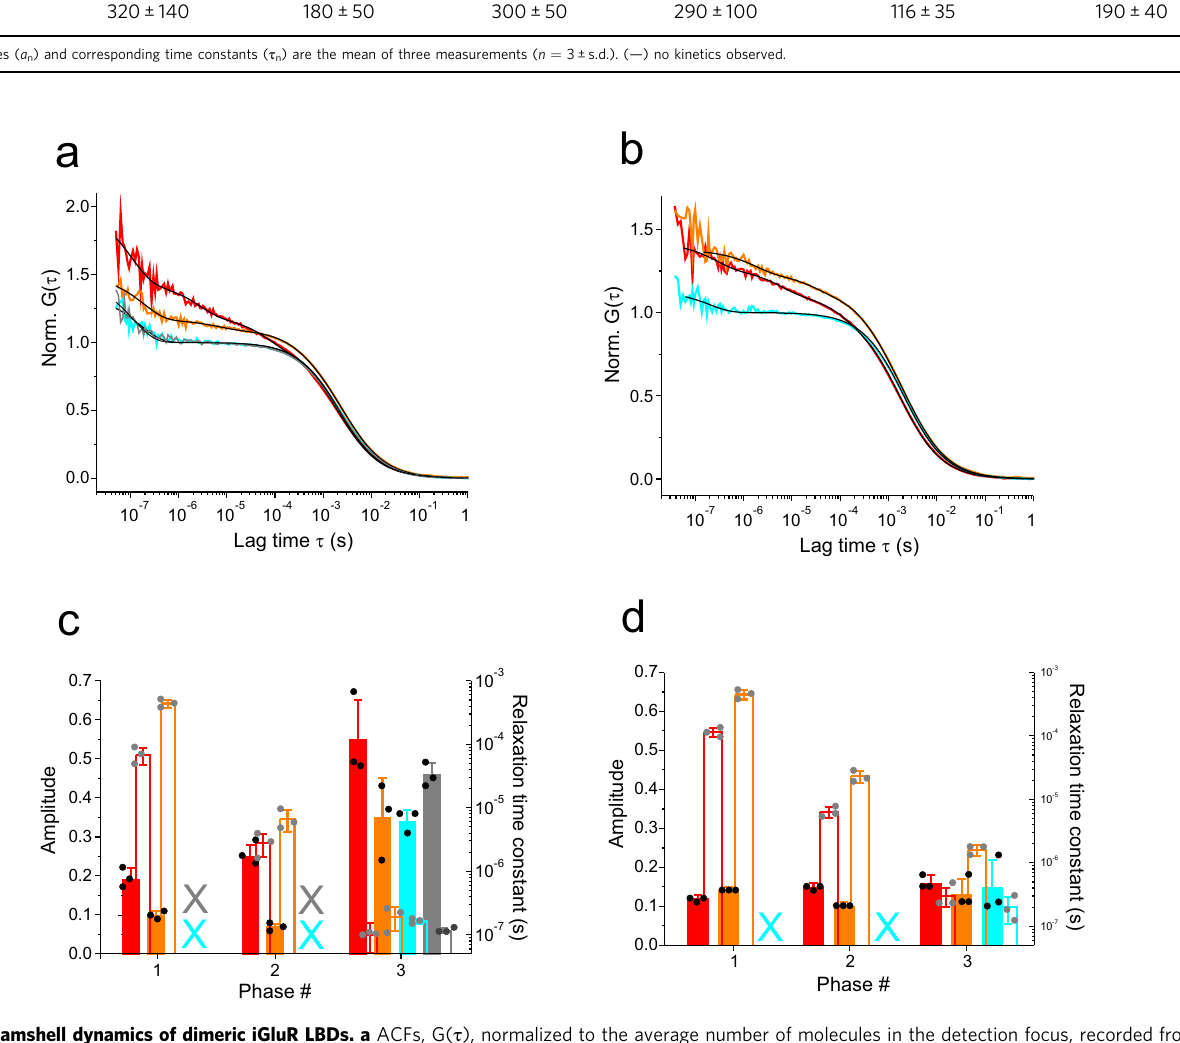
Fig. 4 Clamshell dynamics of dimeric iGluR LBDs. a ACFs, G( τ ), normalized to the average number of molecules in the detection focus, recorded from GluA2-LBD-G446C-T685W-L483Y (apo monomer, red) and in presence of excess GluA2-LBD-L483Y (apo dimer, orange). ACFs of the dimer in presence of the agonists Glu and AMPA are shown in cyan and gray (agonist-bound dimers). b ACFs recorded from GluN1-LBD-A480C-N521Y (apo monomer, red) and in presence of excess GluN2A-LBD-E516Y (apo hetero-dimer, orange). The ACF of the GluN1-GluN2A hetero-dimer in presence of the agonist Gly is shown in cyan. Black lines are fi ts to the data using a model for molecular diffusion containing a sum of one to three single-exponential decays (indicated in ( c , d )). c Amplitudes (closed bars) and corresponding time constants (open bars) of exponential decays of ACFs of the monomeric and dimeric GluA2 LBD in apo and agonist bound states. Data sets and color code correspond to the ACFs shown in panel ( a ). Crosses (X) denote missing (not detected) kinetics. d Amplitudes (closed bars) and corresponding time constants (open bars) of exponential decays of ACFs of the monomeric and hetero-dimeric GluN1 LBD in apo and agonist-bound states. Data sets and color code correspond to the ACFs shown in panel ( b ). Crosses (X) denote missing (not detected) kinetics. Error bars are s.d. of three measurements ( n =